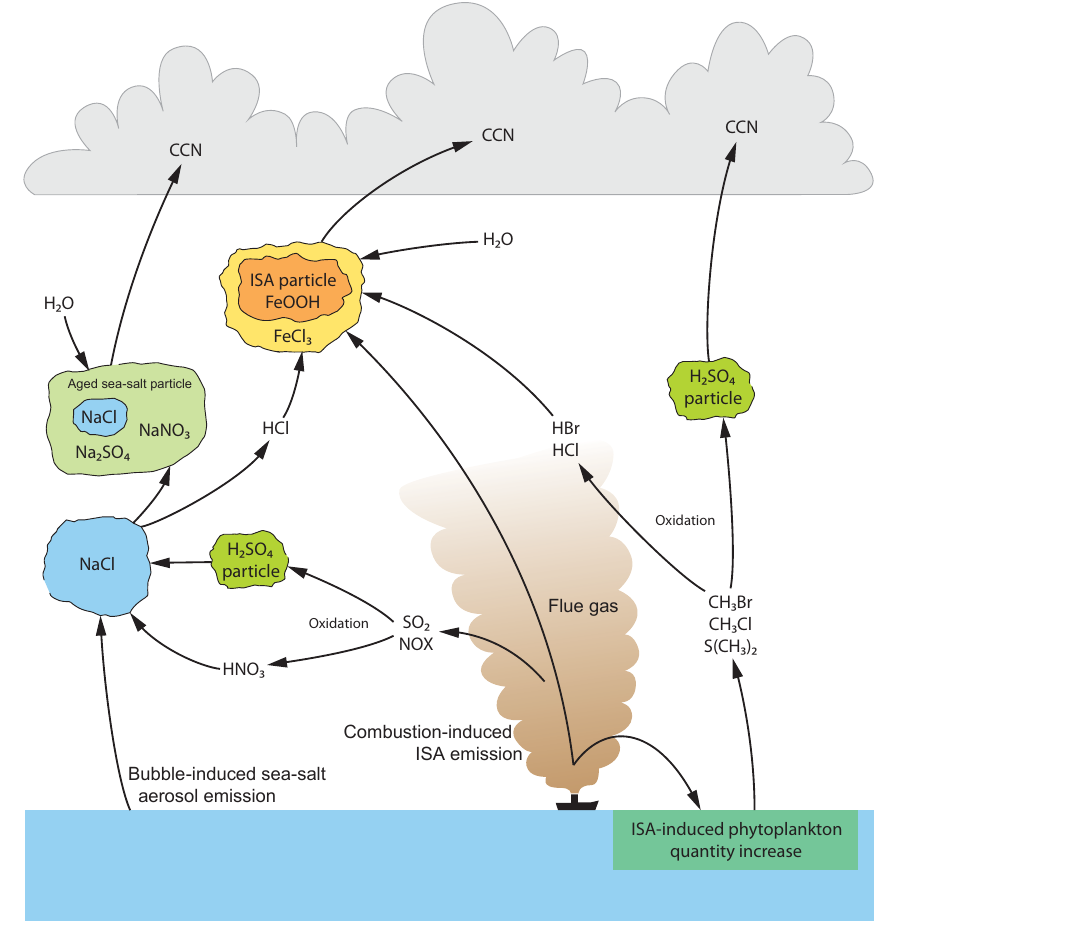
Figure 1. Process of tropospheric cooling by direct and indirect increasing of the quantity of different cloud condensation nuclei (CCN) inducing albedo increase by cloud formation at low supersaturation, cloud whitening and cloud life